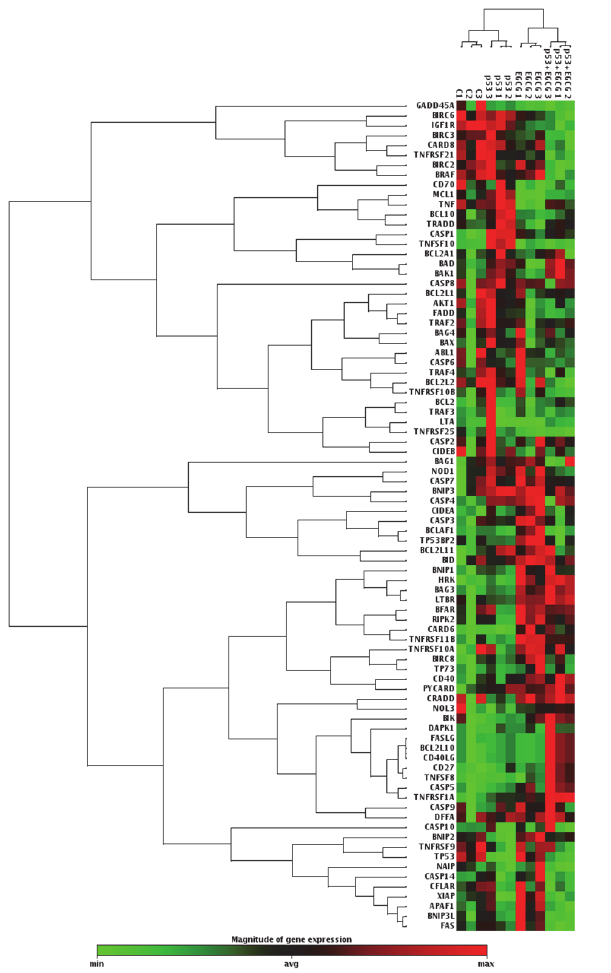
Fig 2. Expression matrix of triple negative breast cancer cells after treatment with p53 siRNA, EGCG, and combined treatment. According to the bar shown below the matrix, upregulated genes are represented in red and downregulated genes are represented in green. Small black squares represent unaltered genes. Each row represents color codes for a specific gene and each column indicates the treatment strategy, which was performed in